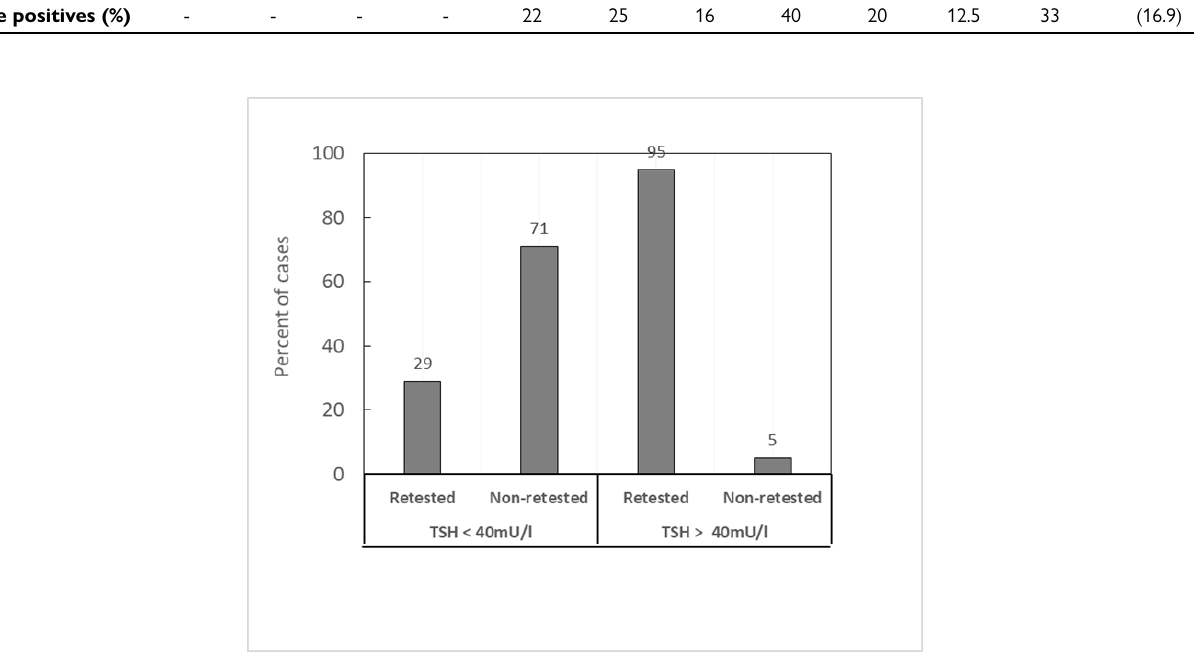
Figure 3. Percentages of retested and non-retested children who were positive at CH screening, considering their cord-blood TSH level (less than 40 mu/L or above 40